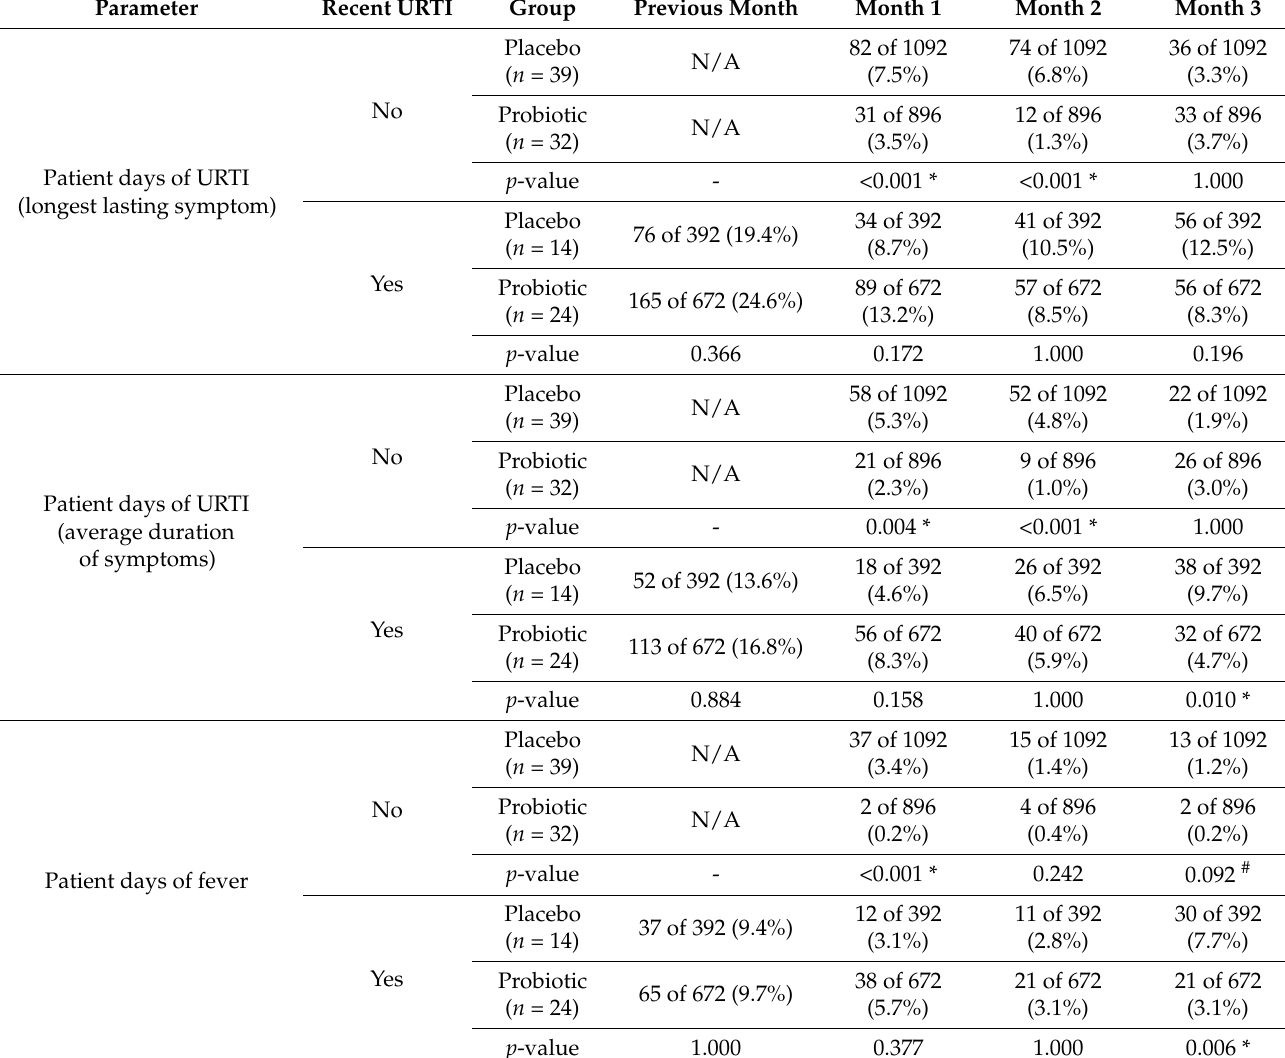
Table 3. Proportion of patient days for longest lasting symptom, average symptom duration and fever from 109 adult subjects randomly assigned to 12 weeks of double-blind treatment with either 10 9 CFU/day L. plantarum DR7 ( n = 56) or placebo ( n =